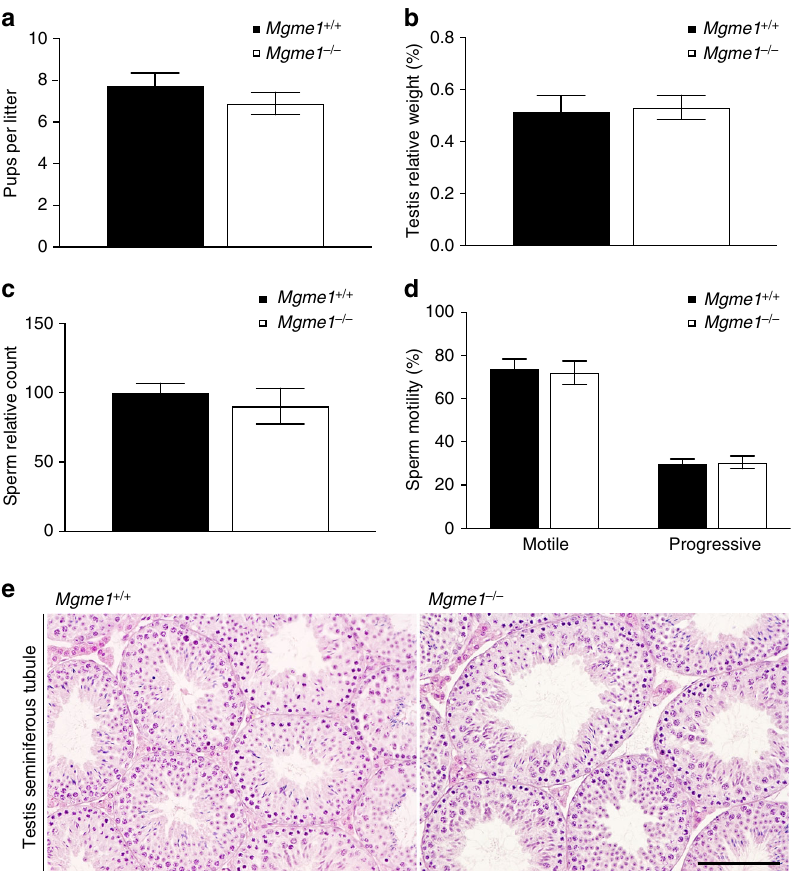
Fig. 3 Mgme1 − / − male mice are fertile and show normal testes morphology. a Pups per litter (data from 7 different males). b Relative testis weight. c Relative sperm count. d Sperm motility. e Testis seminiferous tubule structure. Scale bar, 100 µ m. Data represent mean ± SEM. Statistical analyses were performed using Student ’ s t -test. n = 3 biological